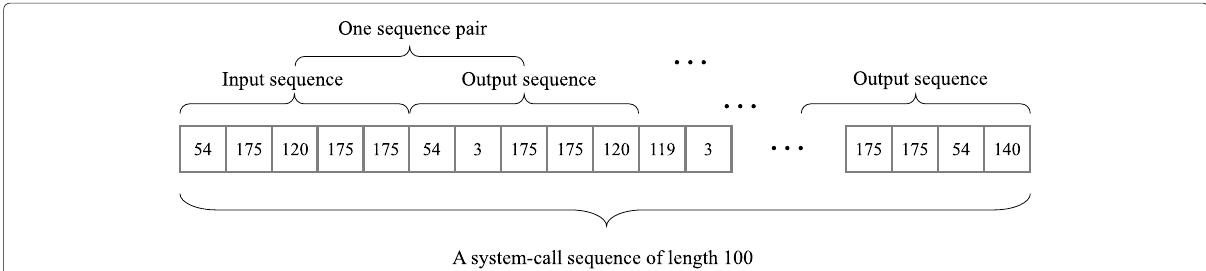
Fig. 7 ROC curves and AUC values of intrusion detection models trained on the original sequences and the augmented sequences